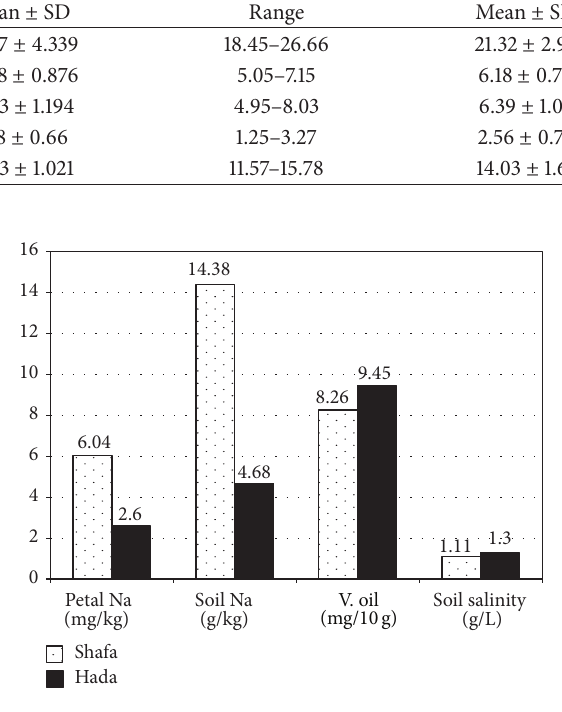
Figure 3: Comparison between the mean levels of total sodium in petals and soil, soil salinity, and the amount of volatile oil in petals of both Shafa and